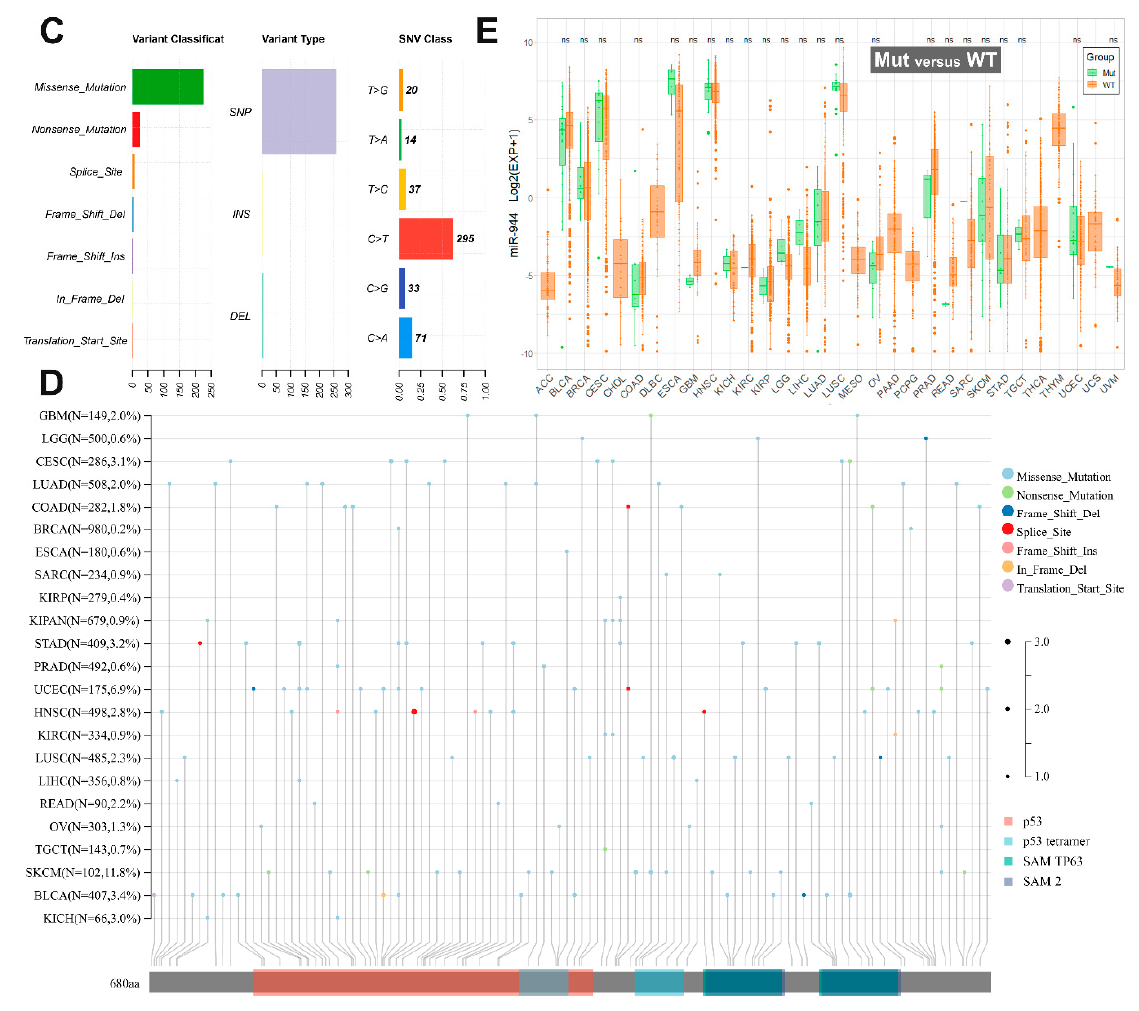
Figure 1. Pan-cancer analysis of miR-944 based on TCGA database. ( A ) Histogram of median quantile expression of miR-944 in non-tumor and tumor groups in the TCGA database. The blue font indicates that miR-944 is significantly low expressed in this cancer type; the red font indicates that miR-944 is significantly highly expressed in this cancer type; ( B ) comparison of miR-944 expression levels between non-tumor and tumor groups in the TCGA database. *** means p < 0.0000625; ** means p < 0.000625; * means p < 0.003125; ns means no significant difference; ( C ) overview of SNVs of TP63; ( D ) mutation types in TP63 protein domains in various cancers; ( E ) differences in the expression level of miR-944 between the TP63 mutant group (Mut) and the wild group (WT). Ns means no significant difference. ACC, adrenocortical carcinoma; BLCA, bladder urothelial carcinoma; BRCA, breast invasive carcinoma; CESC, cervical squamous cell carcinoma and endocervical adenocarcinoma; CHOL, cholangiocarcinoma; COAD, colon adenocarcinoma; DLBC, lymphoid neoplasm diffuse large B-cell lymphoma; ESCA, esophageal carcinoma; GBM, glioblastoma; HNSC, head and neck squamous cell carcinoma; KICH, kidney chromophobe; KIRC, kidney